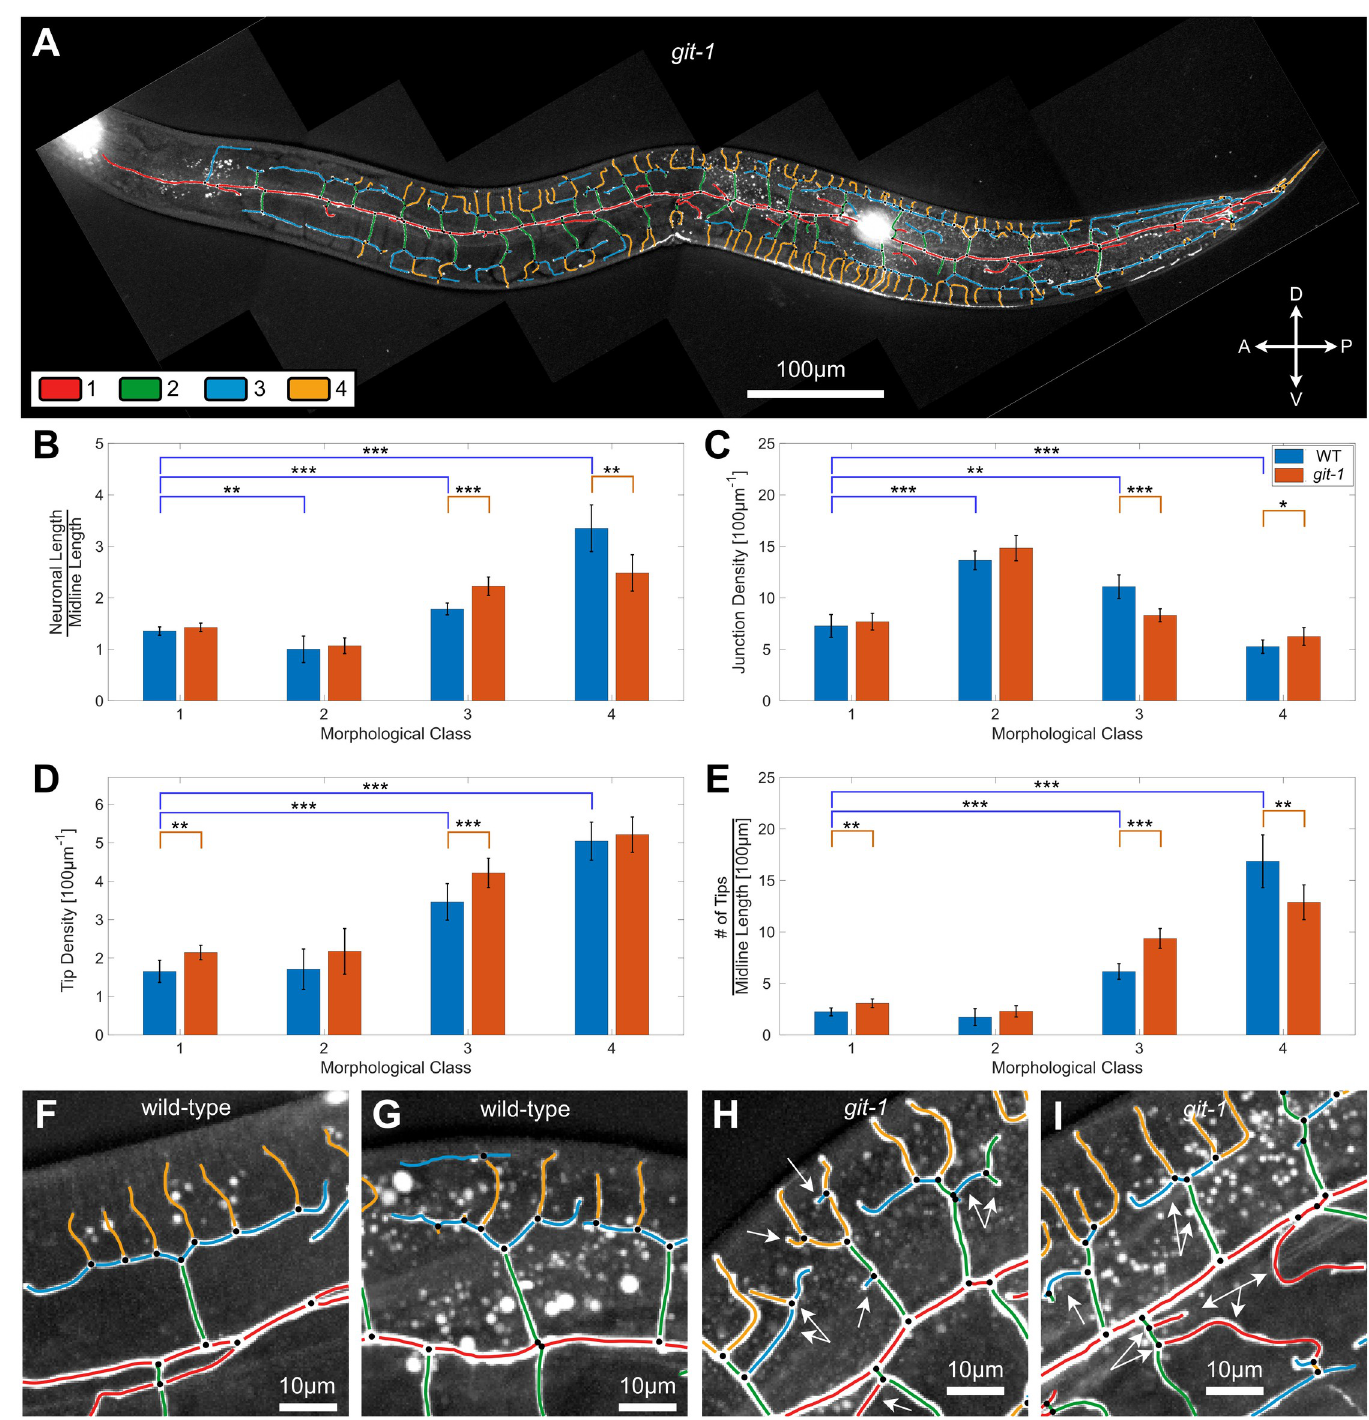
Fig 6. Distributions of geometrical PVD elements in wild-type and git-1 mutant. A. An image of a full PVD of a git-1 mutant, superimposed with color-coded morphological classes: class 1 (red), class 2 (green), class 3 (blue) and class 4 (yellow). B. Total PVD length for each morphological class for WT (blue) and git-1 mutant (red), normalized to the whole PVD midline length. C. The length density of junctions along the dendritic processes (reciprocal of the average length of dendrites between junctions normalized per 100 μ m), for each morphological class. D. The length density of tips along the dendritic processes, normalized per 100 μ m, for each morphological class. E . The number of dendritic tips, normalized per 100 μ m of midline length, for each of the four morphological classes. F-I. Magnified regions of typical PVD morphologies in wild-type (F-G) and git-1 (H-I). Arrows show abnormal branching in git-1 compared to wild-type. This includes excess of junctions and tips, as well